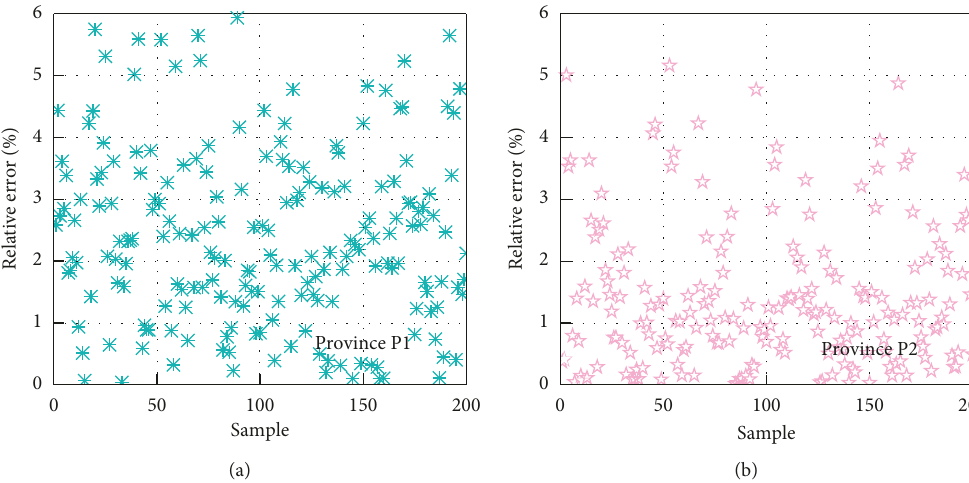
Figure 9: Relative errors between the predicted and real public acceptance in two provinces: (a) province � “ P 1;” (b) province � “ P